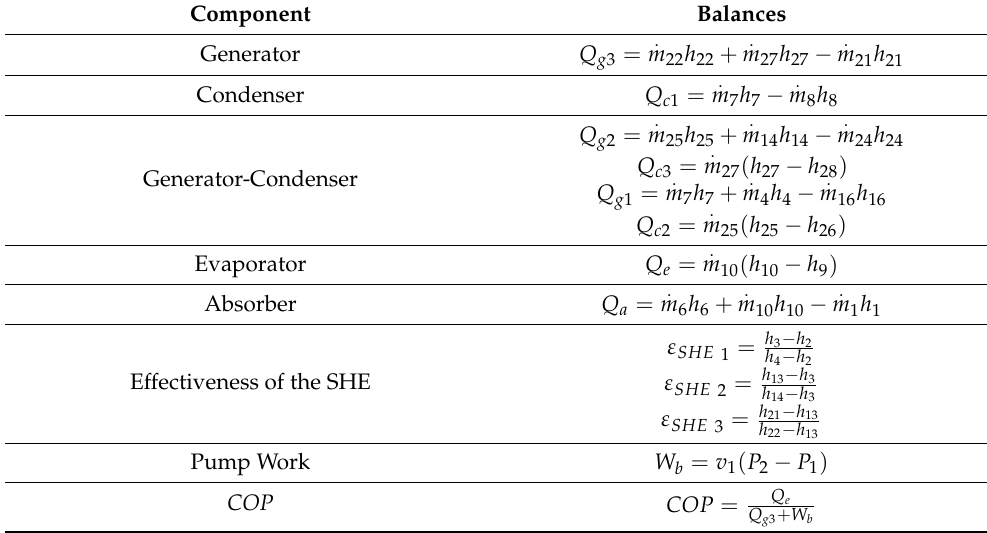
Table A4. Energy balances for each one of the components of the triple-effect absorption cooling